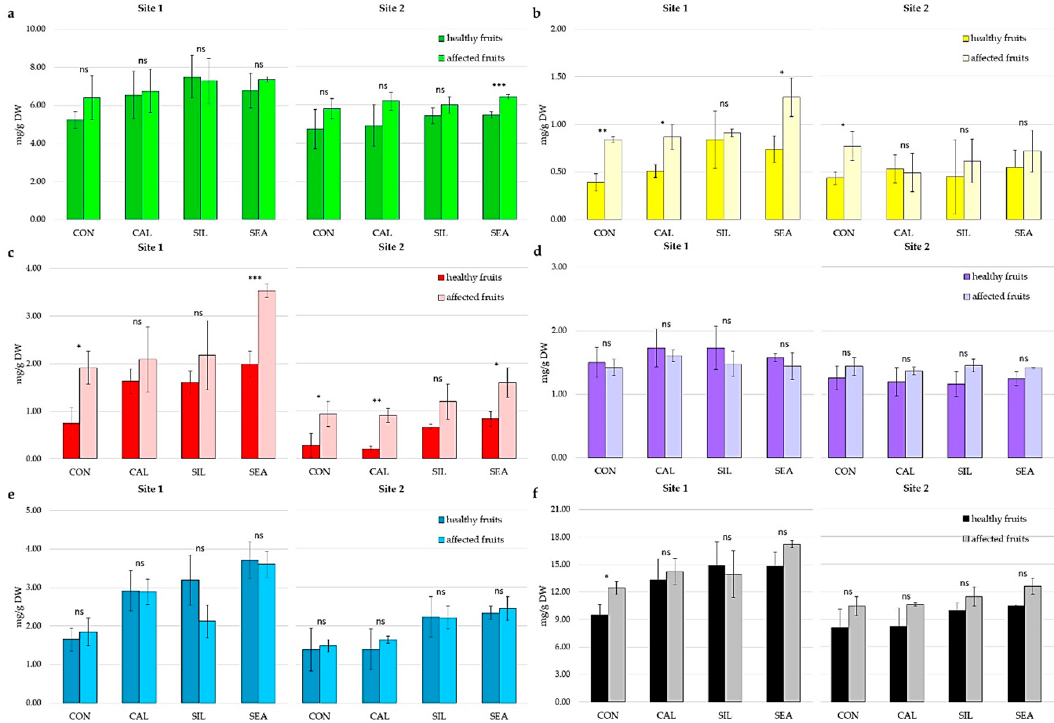
Figure 4. Phenolic content (flavan-3-ols—( a ), hydroxycinnamic acids—( b ), anthocyanins—( c ), dihydrochalcones—( d ), flavonols—( e ), and total—( f )) in apple skin after storage in healthy and symptomatic fruits in site 1 (left) and site 2 (right). Vertical bars indicate mean ± SD ( n = 3). Asterisk on the top of the bar indicates significant differences according to one-way ANOVA (*** p < 0.001; ** p < 0.01; * p < 0.05; ns: not significant).